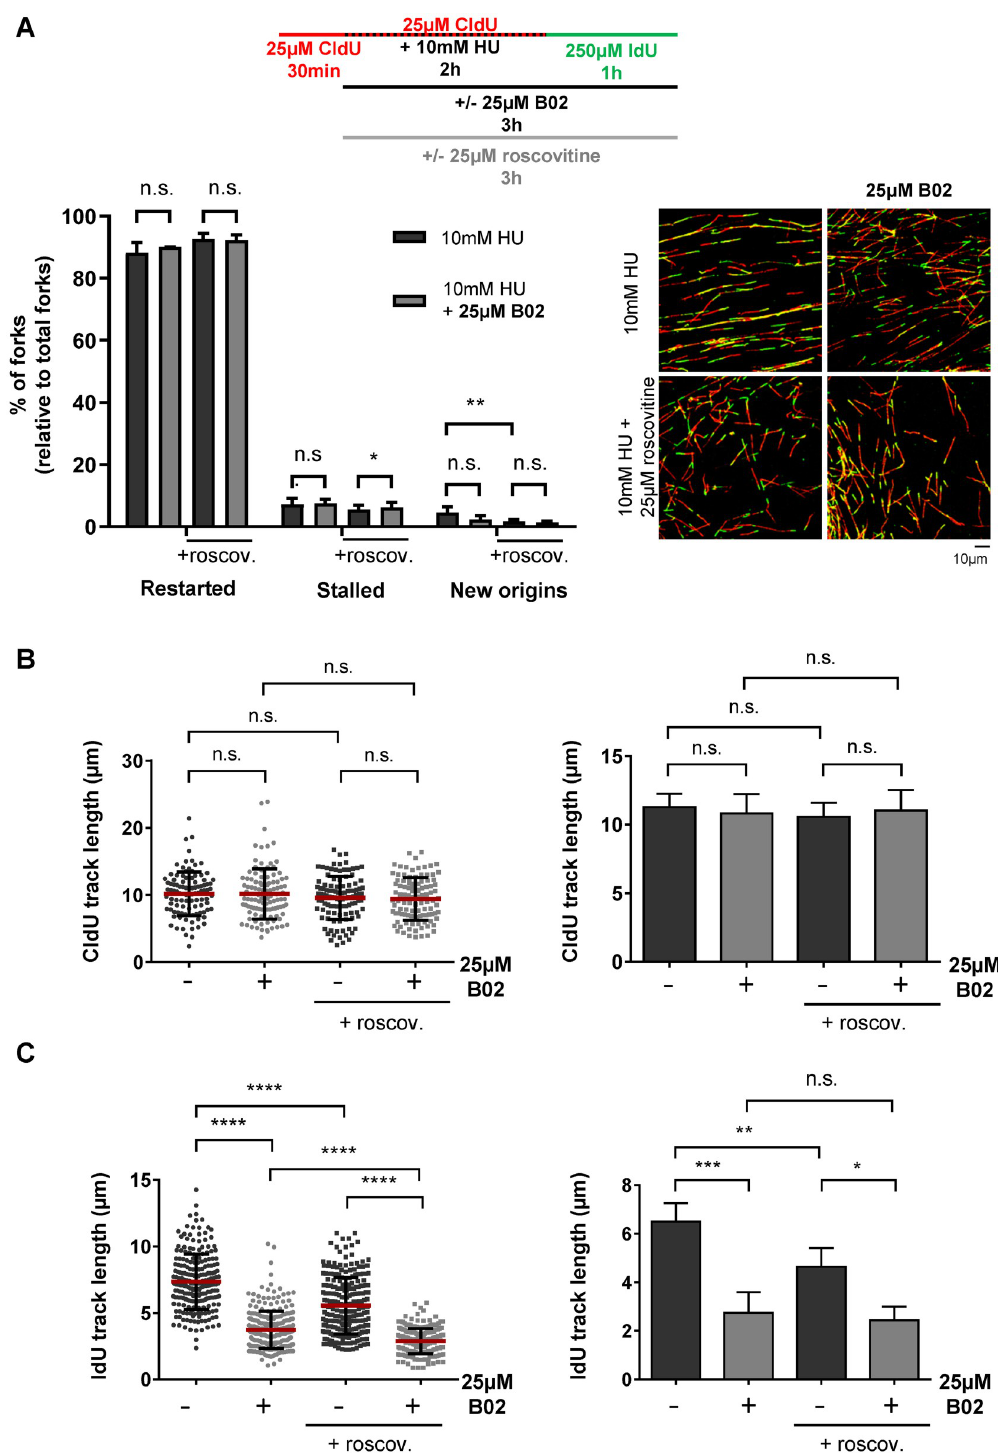
Fig 2. RAD51 inhibition does not affect the number of restarted forks neither causes fork degradation but impairs fork progression after an acute replication stress in hTERT-RPE cells. ( A ) Cells were labelled as indicated (upper panel), adding the B02 inhibitor and roscovitine with 10mM HU and the second analogue. After labelling, cells were harvested and prepared for DNA fiber analysis. At least 200 fibers of each condition in each experiment were used to calculate the percentage of restart, stalled forks and new origin firing events relative to total forks. Representative images are shown (bottom-right panel).